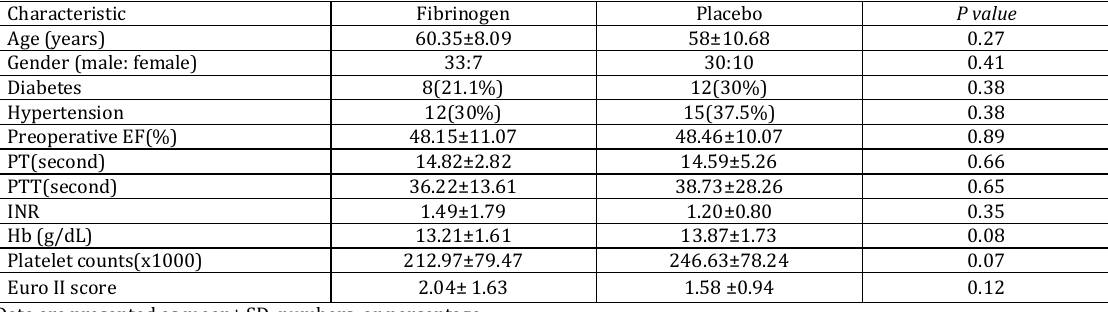
Table 1. Patients’ characteristics Characteristic